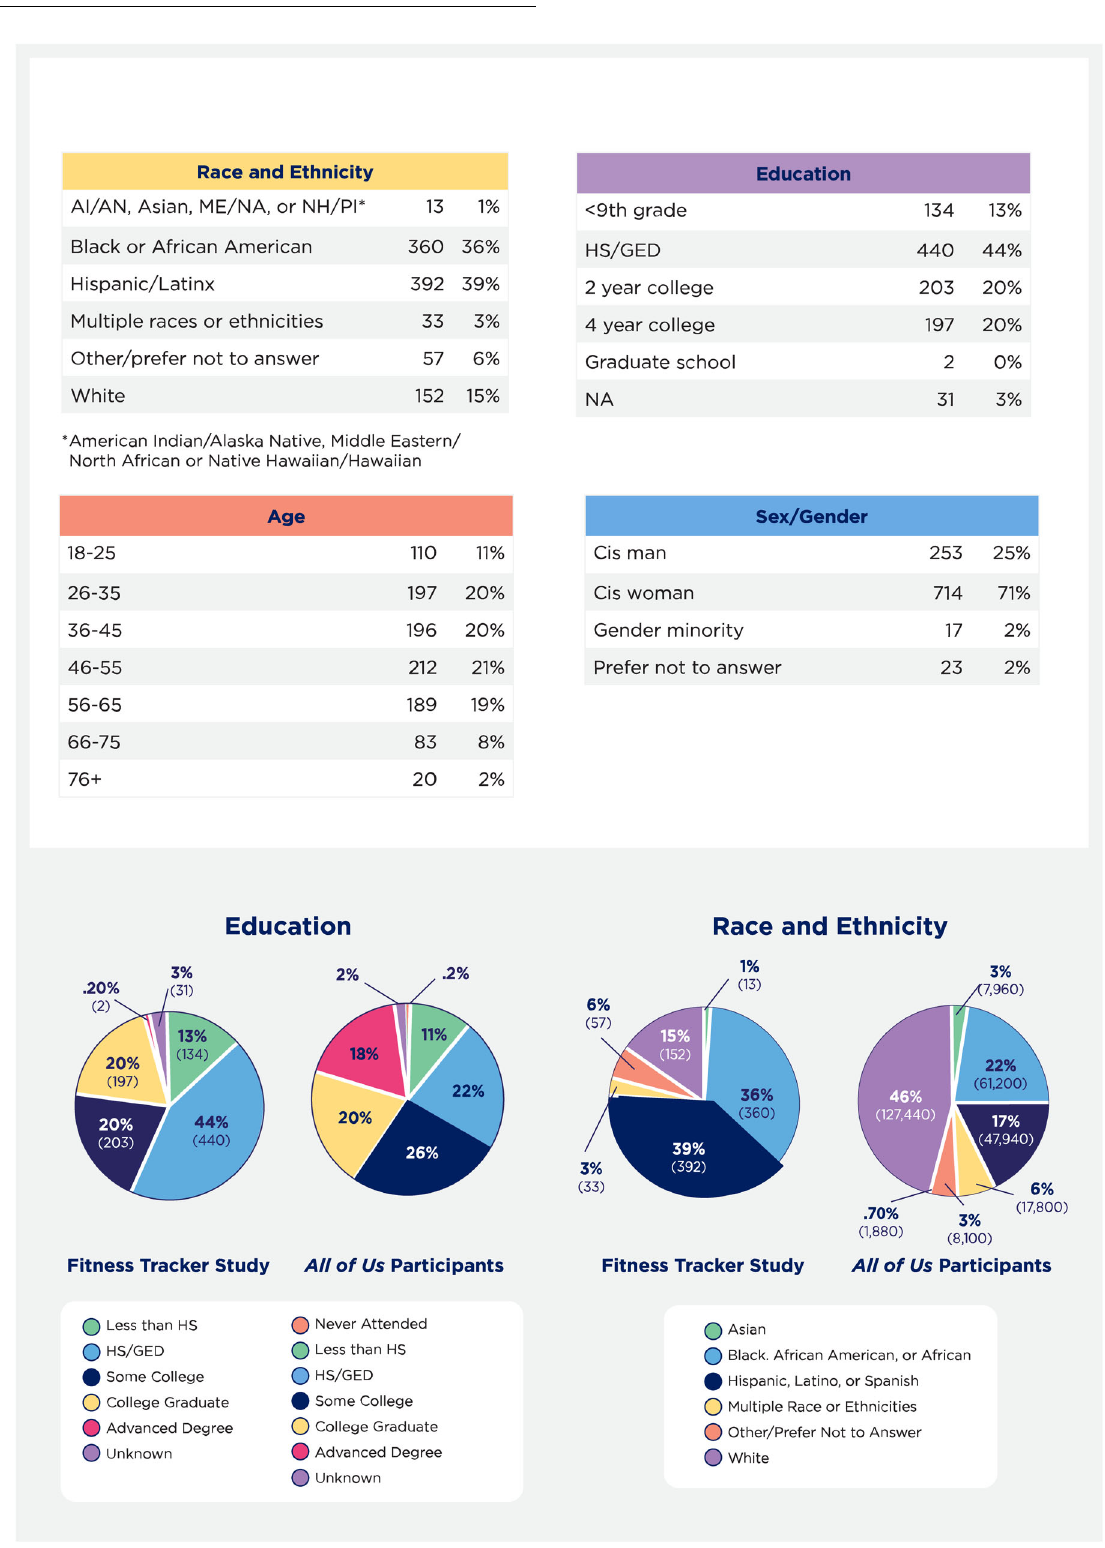
Fig. 1 All of Us Fitness Tracker Survey demographics. Tables show the race/ethnicity, education, age, and sex/gender characteristics of the survey respondents. Pie charts compare the education levels and race/ethnicity of the survey respondents to All of Us Research Program participants. Some All of Us participants are FQHC patients and may have taken part in this survey, but not all survey respondents are enrolled in All of Us